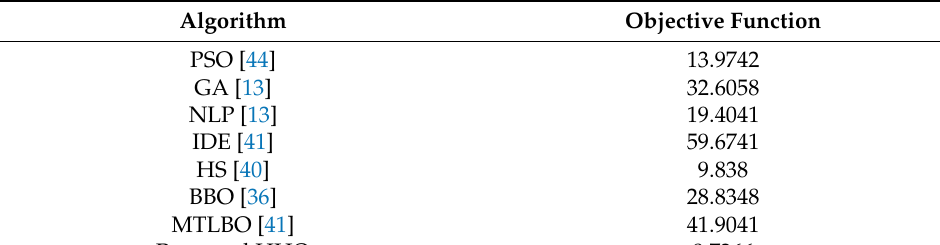
Table 3. Comparison of HHO with other algorithms.